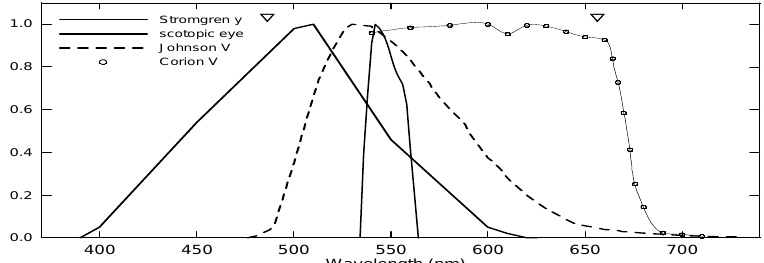
Fig. 3. y , V and Corion normalized transmissions. ∇ : H β and H α